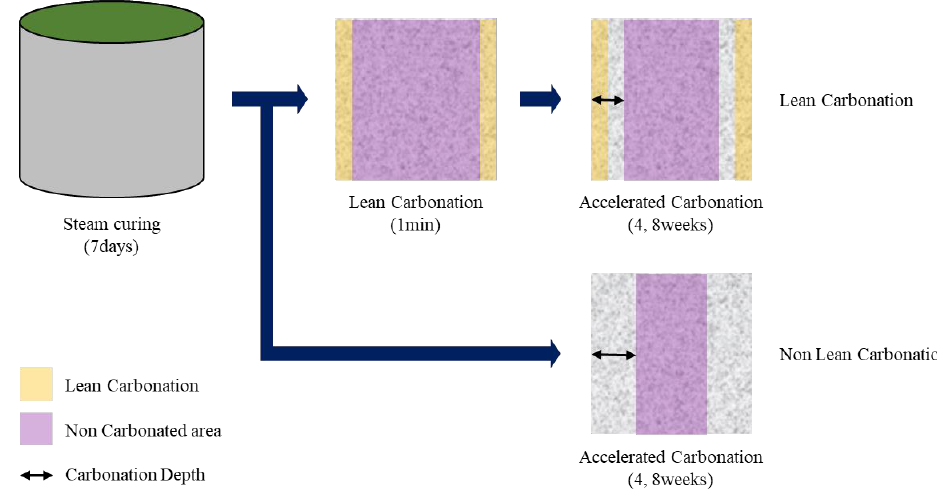
Figure 11. Carbonation resistance evaluation